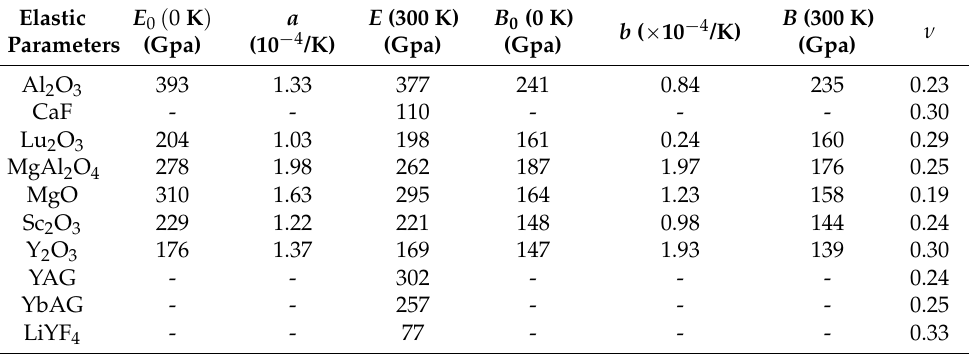
Table 2. Young’s modulus, bulk modulus, and Poisson’s ratio for selected laser